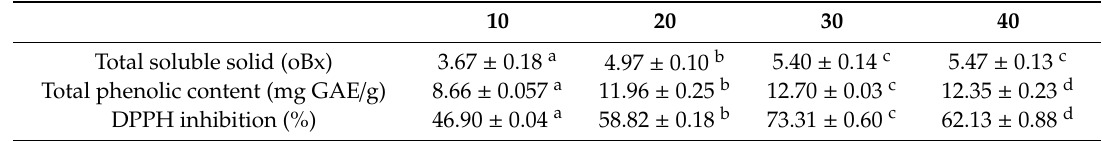
Table 5. E ff ects of brewing time (minutes) on the characteristics of the Roselle